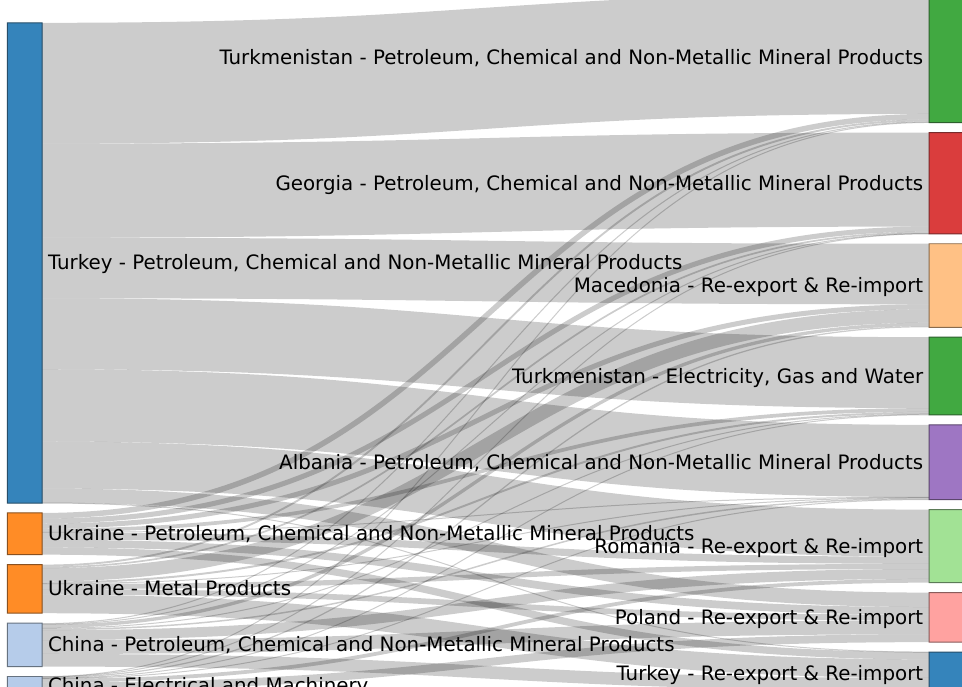
Figure 6. The main EGSR flow relationships at the sector